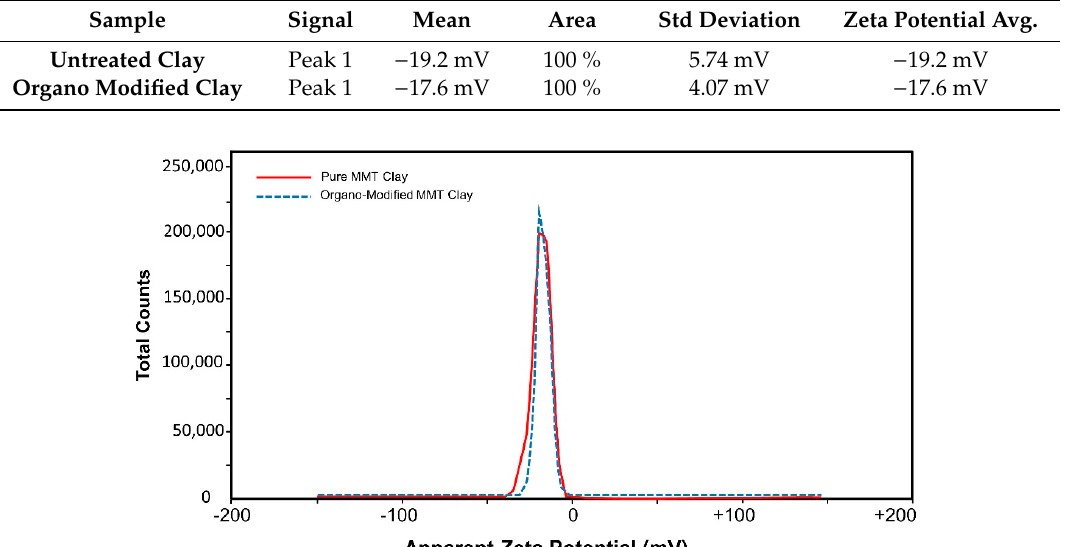
Figure 4. Zeta potential of pure montmorillonite clay and organo modified MMT clay.